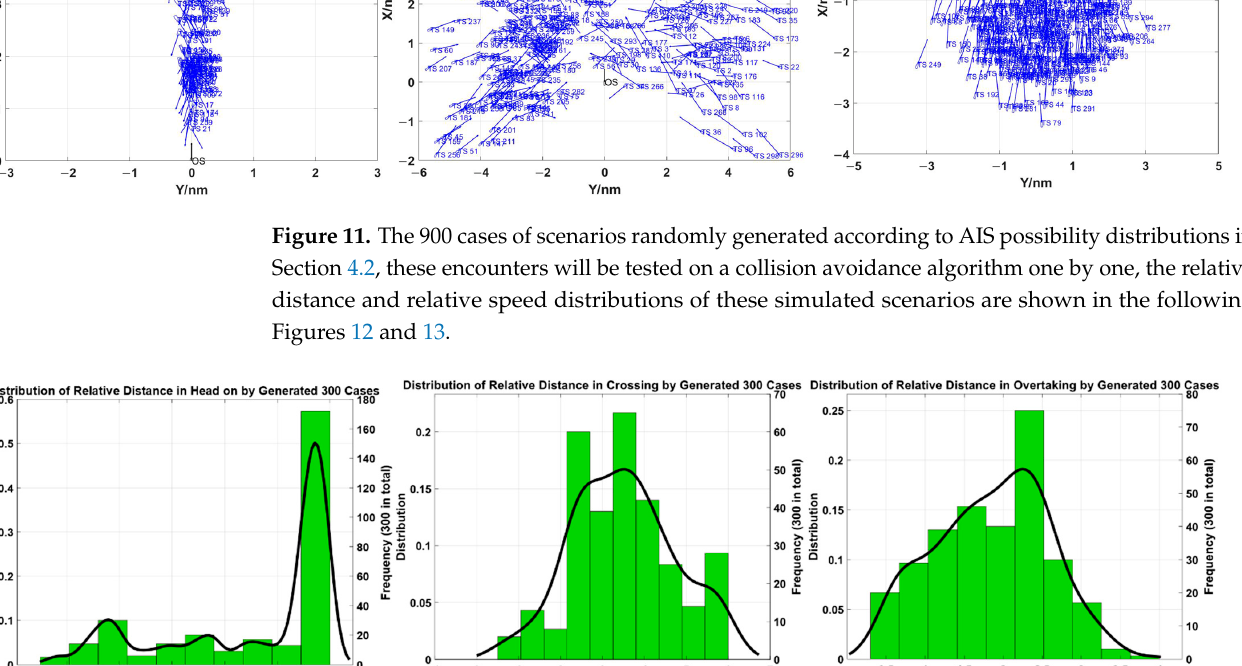
Figure 12. Distributions of initial relative distance for the 900 (300 each encounter) virtual scenario cases complying to the real AIS data in Figure 6. This indicates that our scenario generation program can create scenarios to simulate the real navigation situation in the Laotieshan water area.